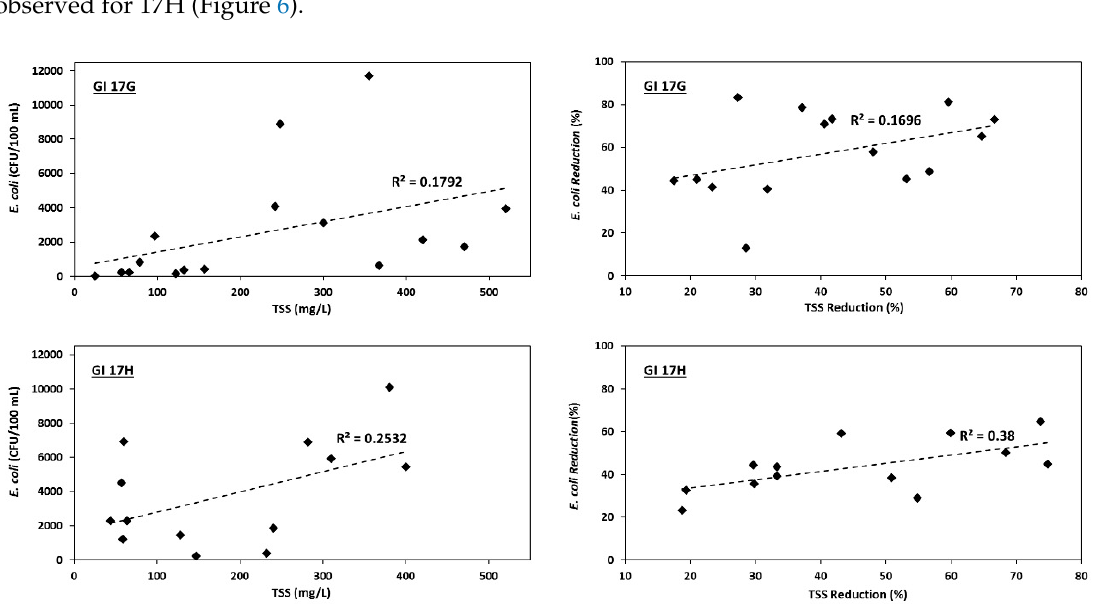
Figure 5. Correlations between E. coli and TSS concentrations, and their reduction percentages.